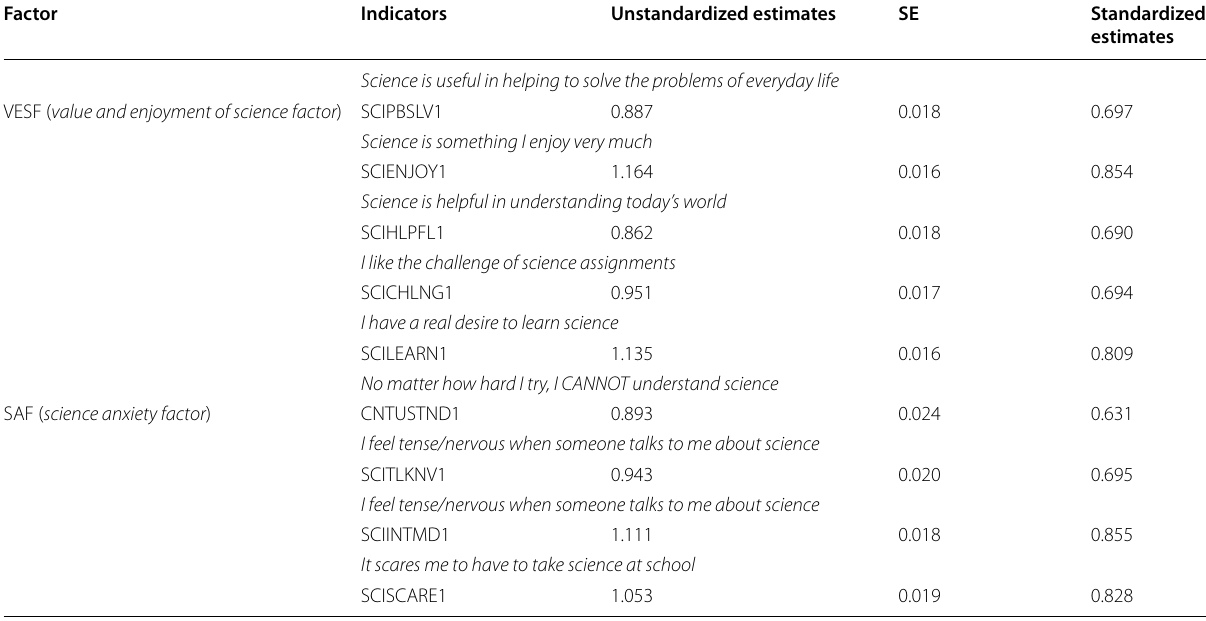
Table 5 Factor loadings and their standard errors: parameter estimates of two‑factor model under the longitudinal strict invariance Factor